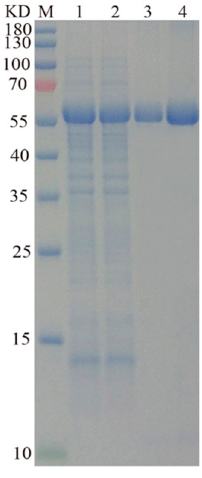
Figure 3. SDS-PAGE analysis of L01. Samples were loaded in di ff erent lanes. Lane M, prestained protein ladder; Lanes 1–2, the concentrated fermentation broth; Lanes 3–4, puri fi ed L01.